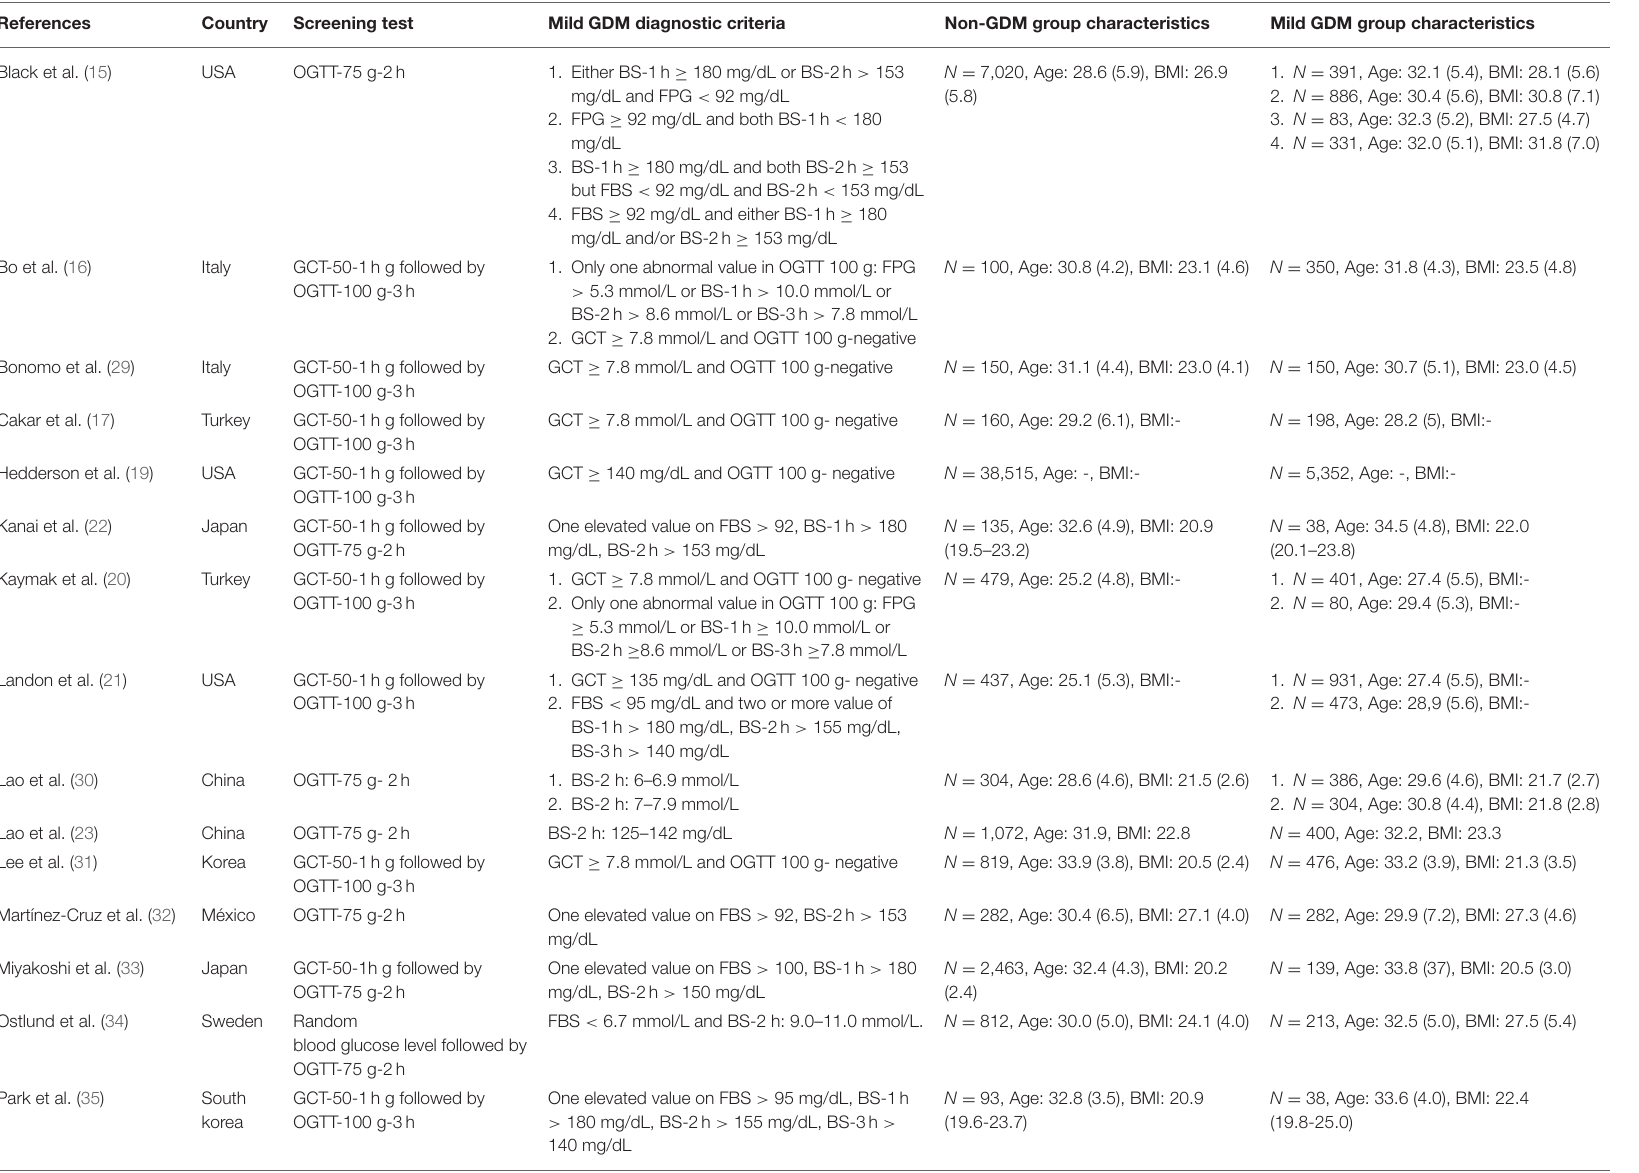
TABLE 1 | Demographic and health-related characteristic of the studies’